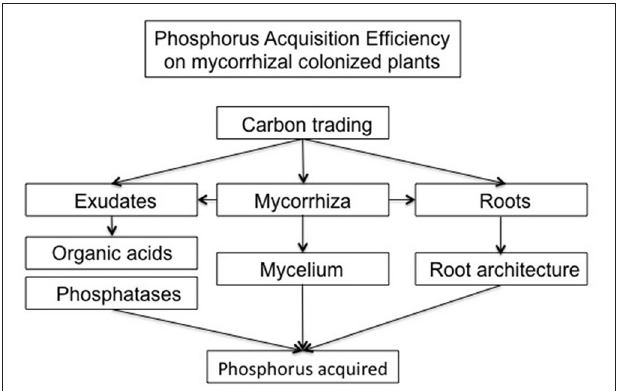
FIGURE 2 | General scheme showing the proposed PAE determination based on carbon trading between all directly related P acquisition traits in AM colonized